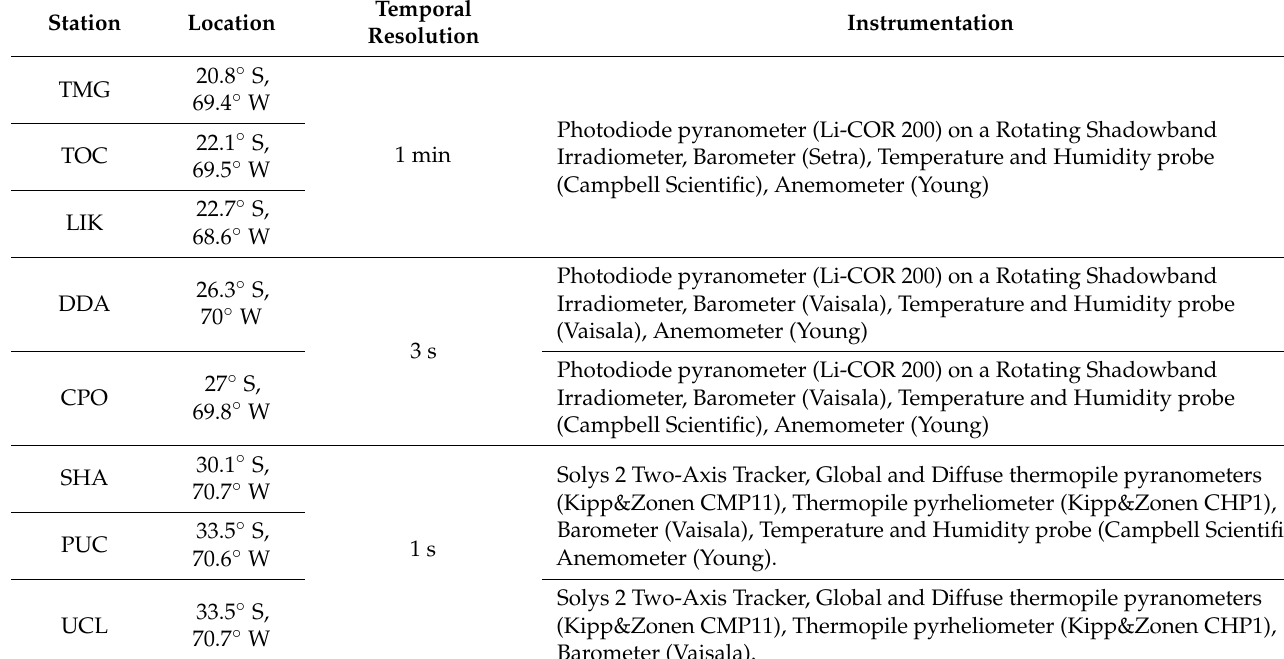
Table 1. Measurement station locations and